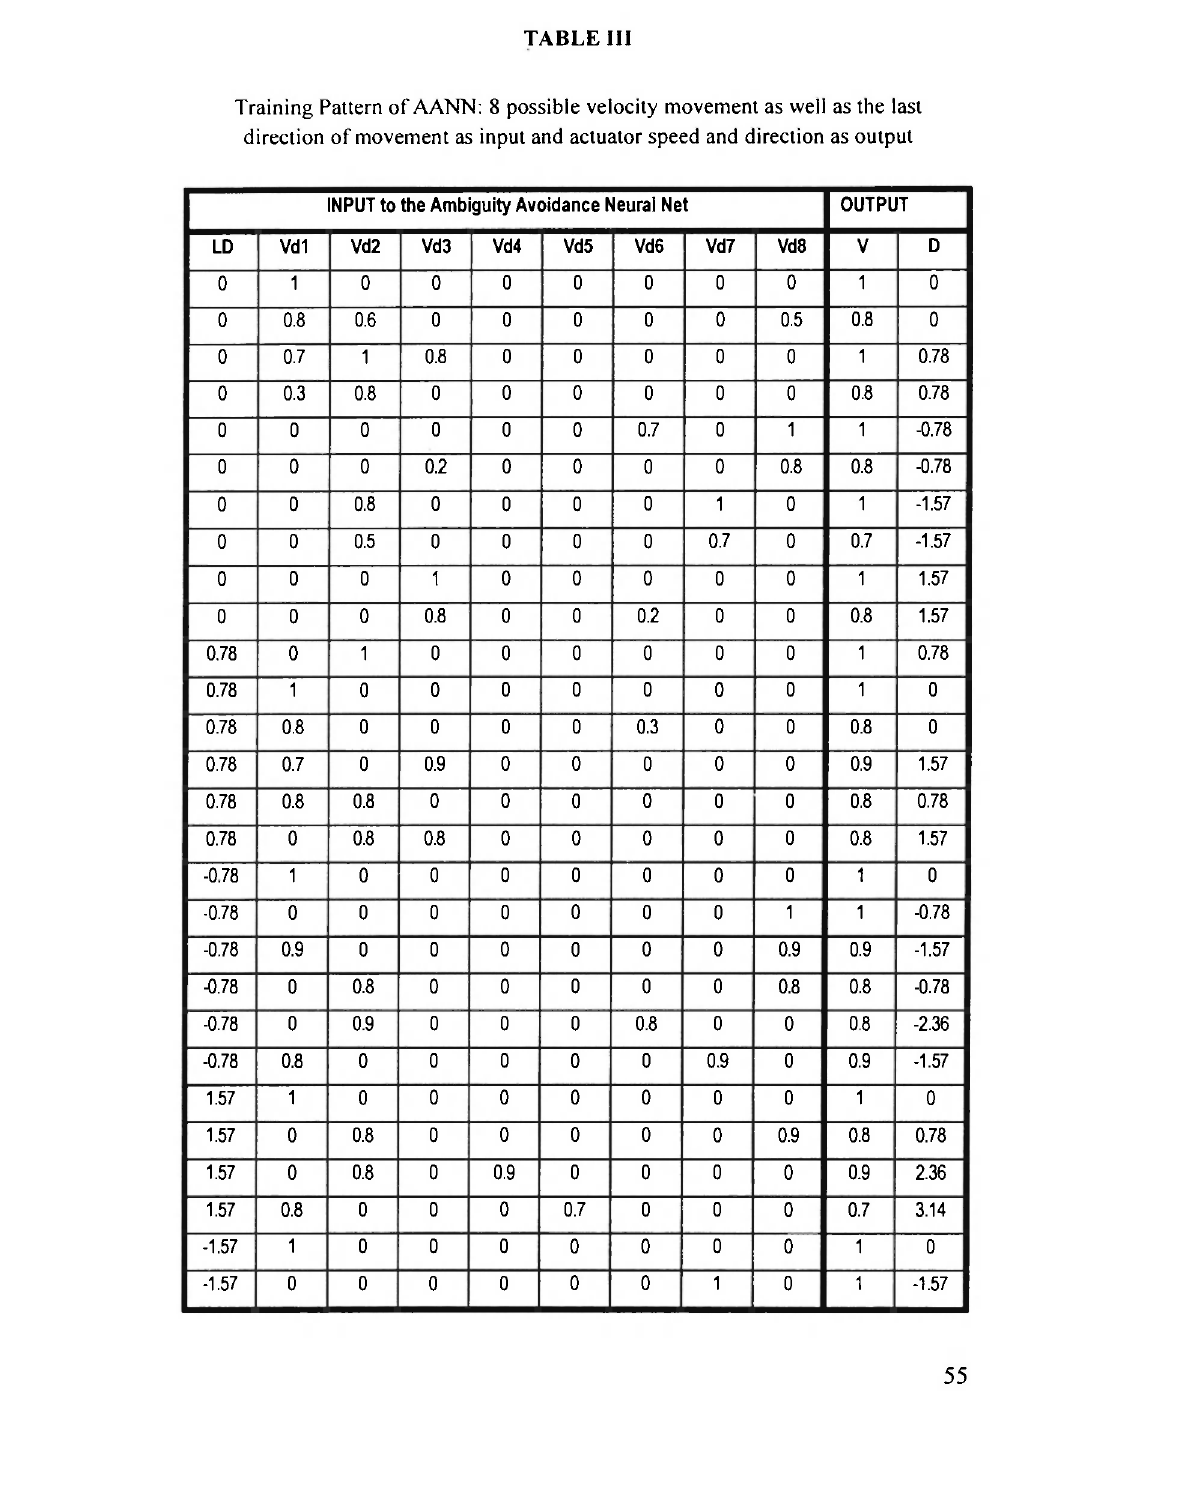
Training Pattern of AANN: 8 possible velocity movement as well as the last direction of movement as input and actuator speed and direction as output